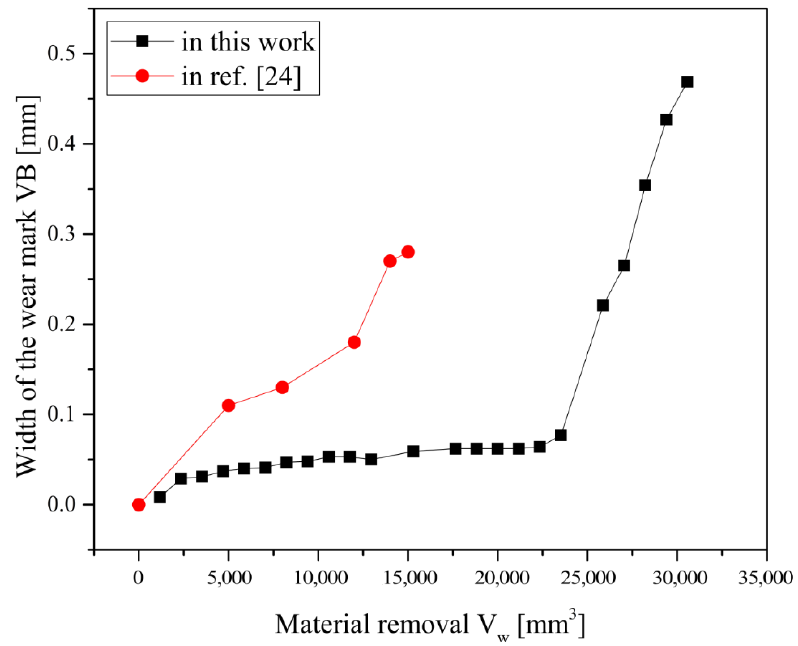
Figure 7. Development of wear for the turning test of WC with the Ti-Al-N coating.